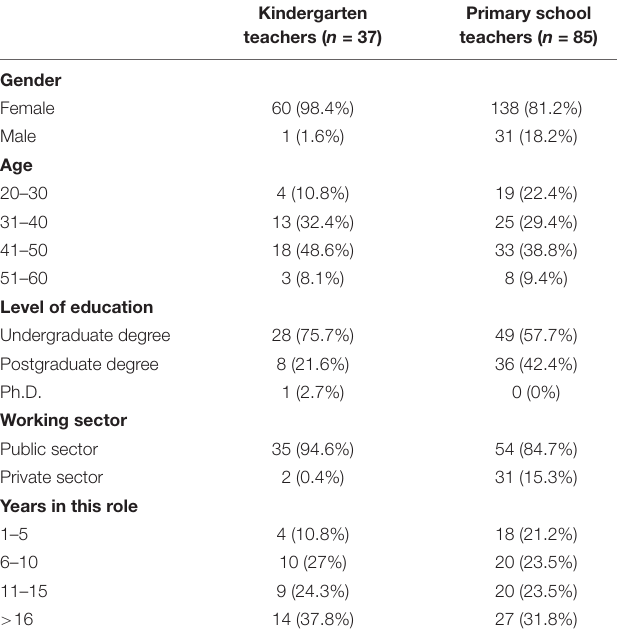
TABLE 1 | Demographics about gender, age, educational level, profession and work